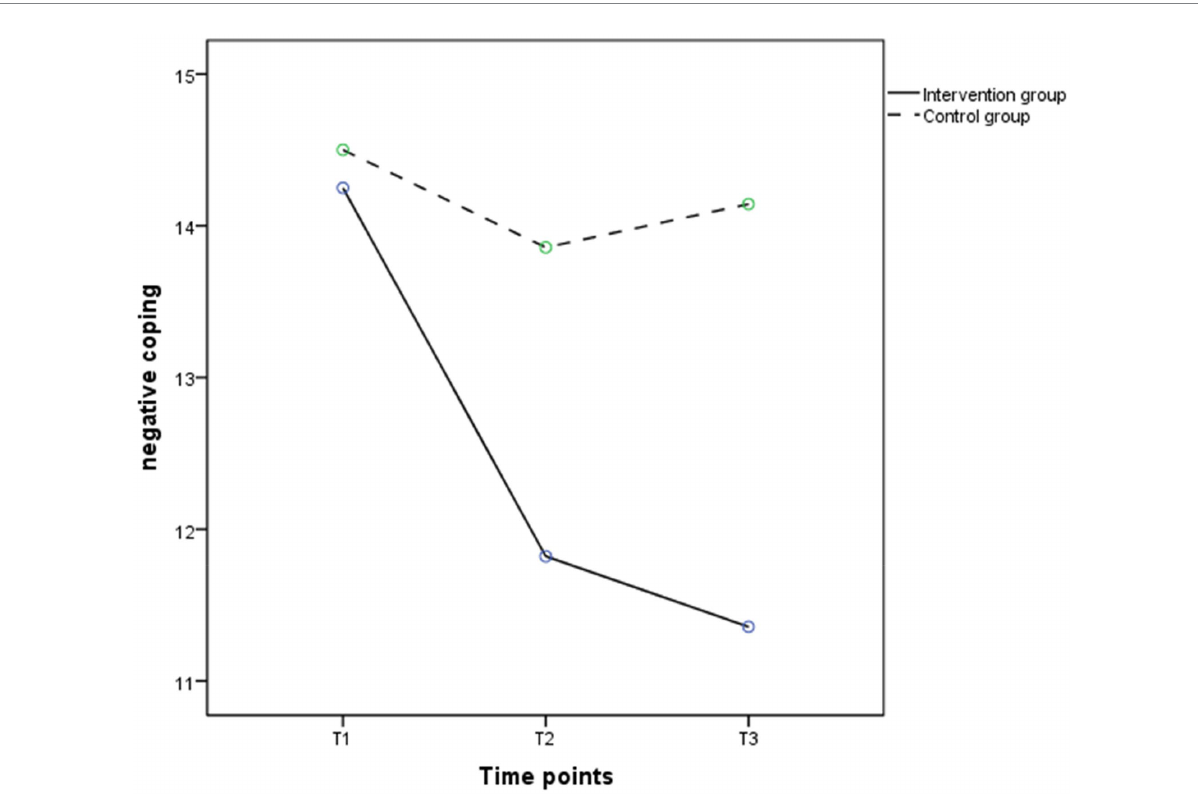
FIGURE 5 The trends in mean scores of negative coping in the intervention (solid line) and control groups (dashed line) between baseline and 3 months post intervention.